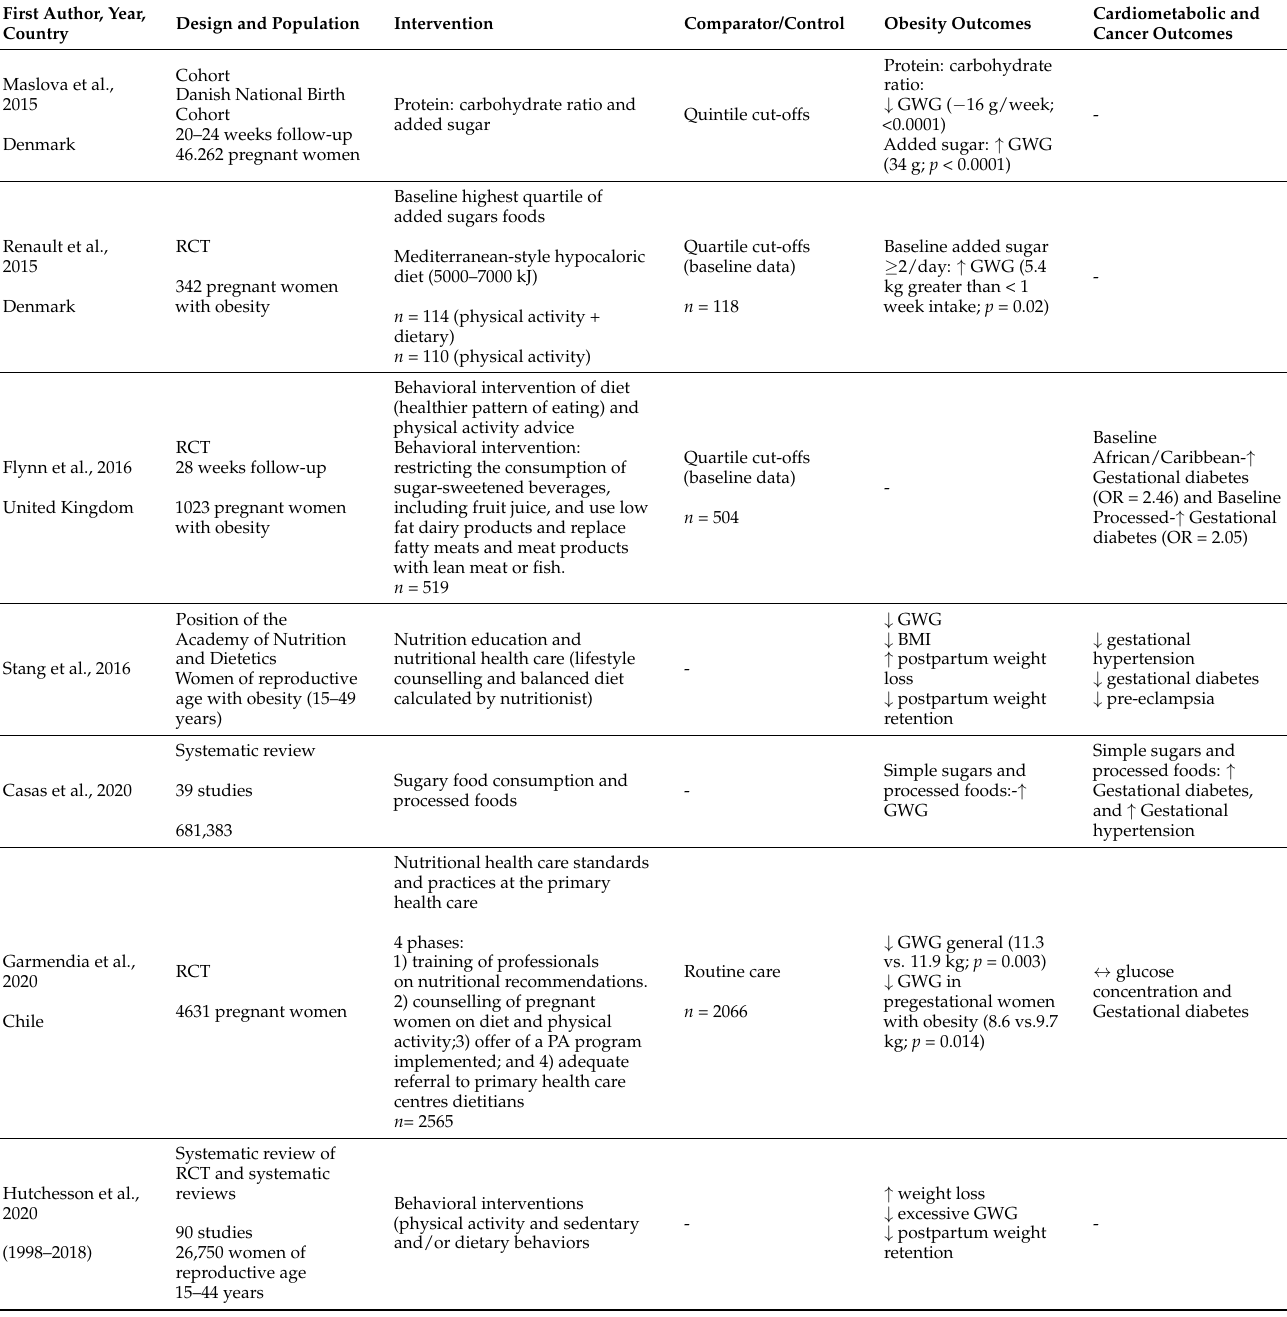
Table 5. Summary of studies with general healthy diet and/or food reduction healthy diets for weight loss, obesity, cardiometabolic and cancer